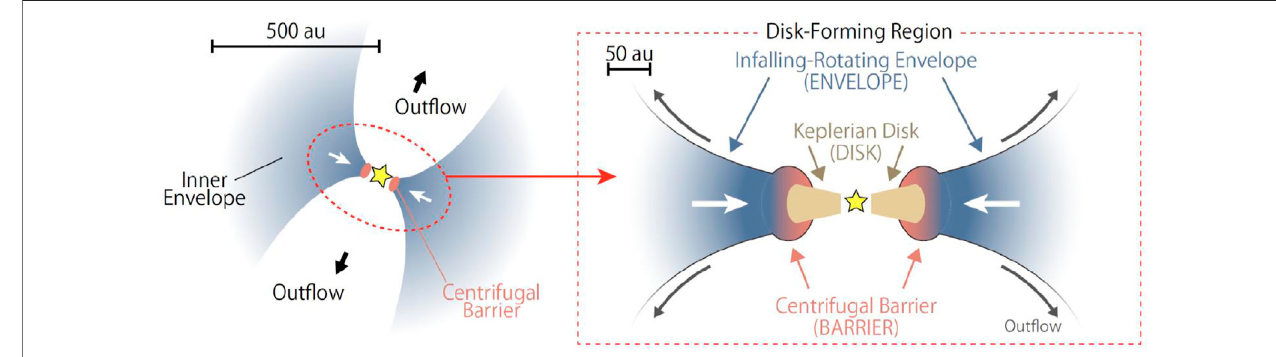
FIGURE 1 | Schematic structure of the region around solar-like Class 0 and I protostars, adapted from the study by Oya et al. (2016). Three main zones can be identi fi ed (see Section 2 ): the infalling and rotating envelope, the centrifugal barrier, and the rotating and accreting